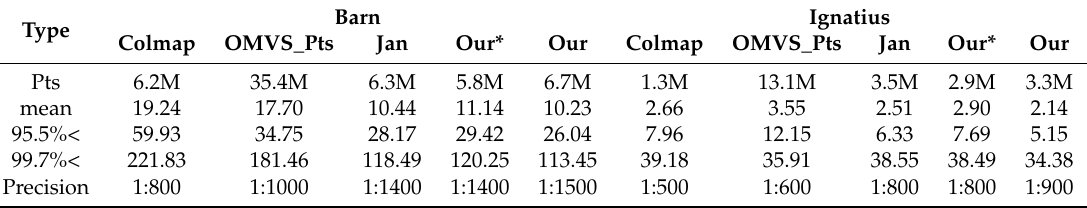
Table 3. Evaluation result of the 3D models evaluated on the training set of Tanks and Temples dataset [40] through the method in [42]. M stands for million. Precision is expressed as a proportion 1:k, where k is the size of the scene divided by the standard error. The unit of all other numbers is